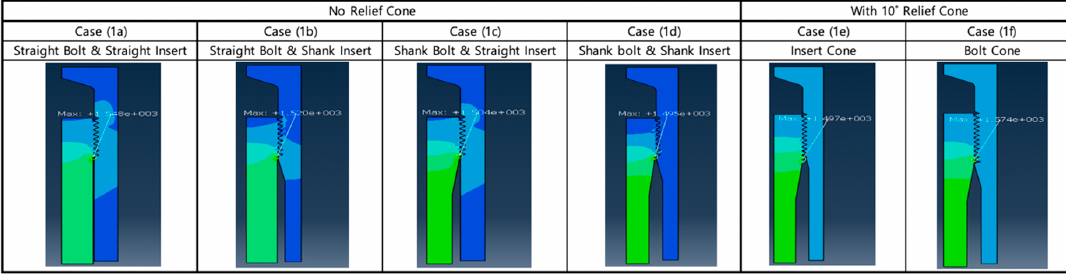
Figure 13. Model comparison (straight or neck-down bolt with/without a relief cone model).